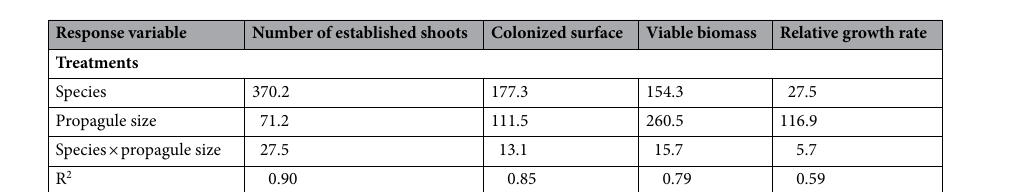
Figure 1. Boxplots of establishment success indicators for the analysed species (coloured) and propagule size classes (small, medium and large). Abbreviations: Ds for D. scoparium, Ha for H. aureum, Hc for H. crupressiforme, Pc for P. capillare, Sr for S. ruralis and Ts for T. squarrosa. Values of number of established shoots, colonized surface and viable biomass were Box–Cox transformed. Bars within each box represent the median, and boxes represent the interquartile range (IQR, top = 75th percentile, bottom = 25th percentile). Whiskers represent the largest/smallest value within 1.5 times IQR. Points represent outliers (> 1.5 times IQR). Compact letter display (CLD) shown as Latin (a, b, c, d and e) and greek letters (α, β and γ) represent, respectively: (1) significant differences across species within the same propagule size, (2) significant differences across propagule sizes within the same species. The values for CLD assignments are the p -adjusted values of pairwise comparisons for planned contrasts (Tables S2.1:S2.8).